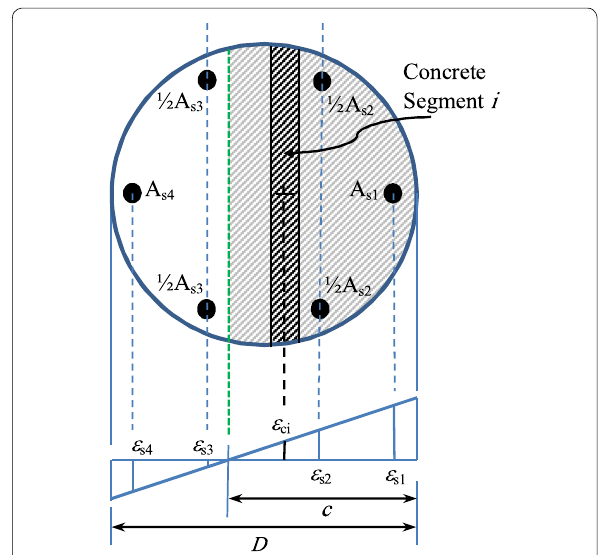
Fig. 8 Linear strain distribution under axial–flexural